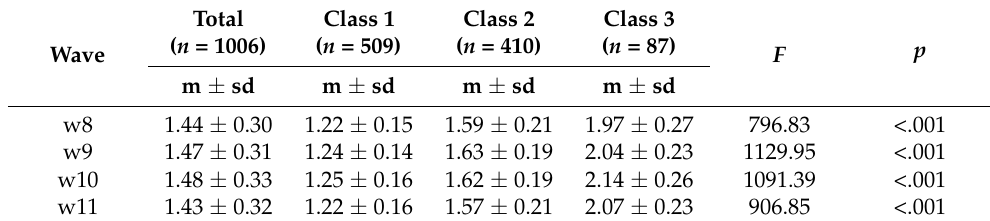
Table 3. Differences among latent layers of children’s EFD at each wave (time). Table 2. Latent Class Growth model for EFD longitudinal pattern in children. Wave